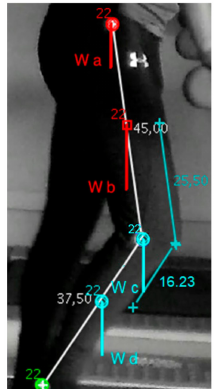
Figure 5. Leg centers of mass.